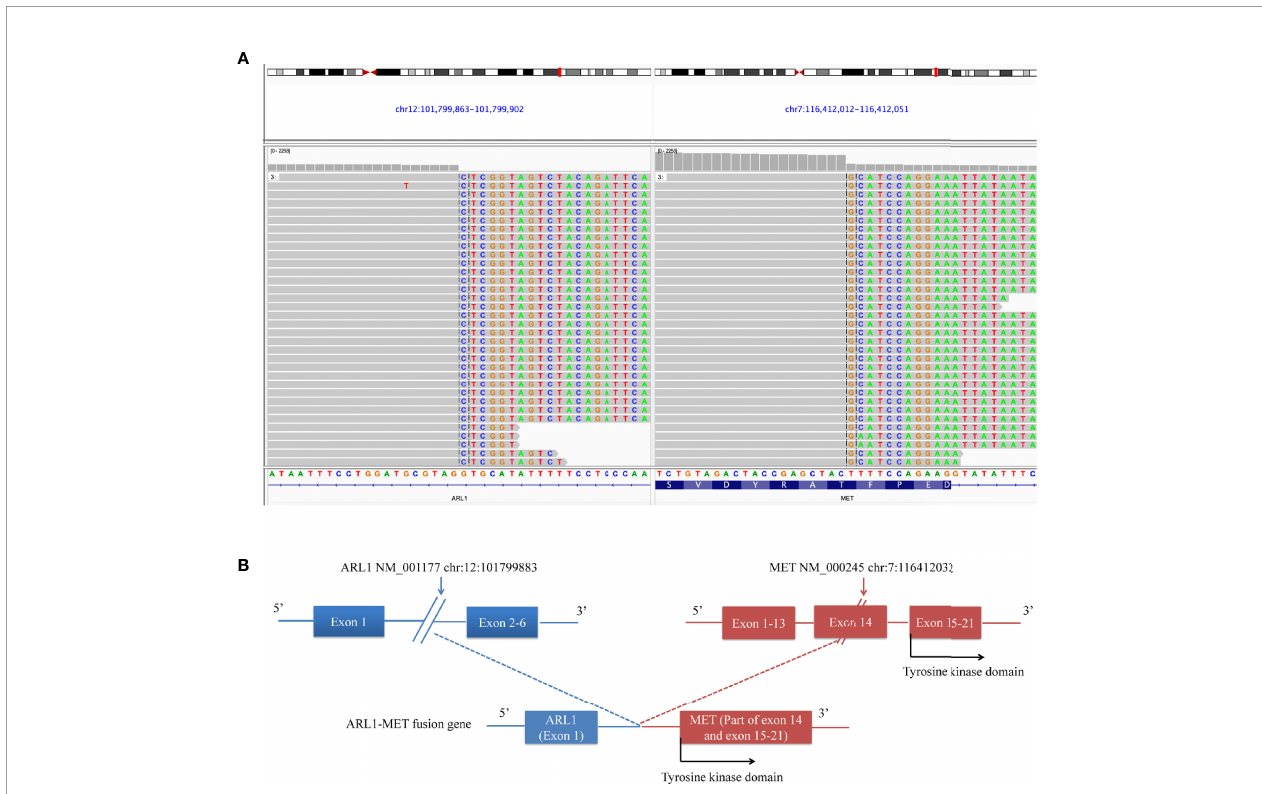
FIGURE 2 | ARL1-MET fusion was detected in the patient. (A) Sequencing reads of the ARL1-MET fusion revealed by the Integrative Genomics Viewer (IGV). (B) Illustration of ARL1-MET